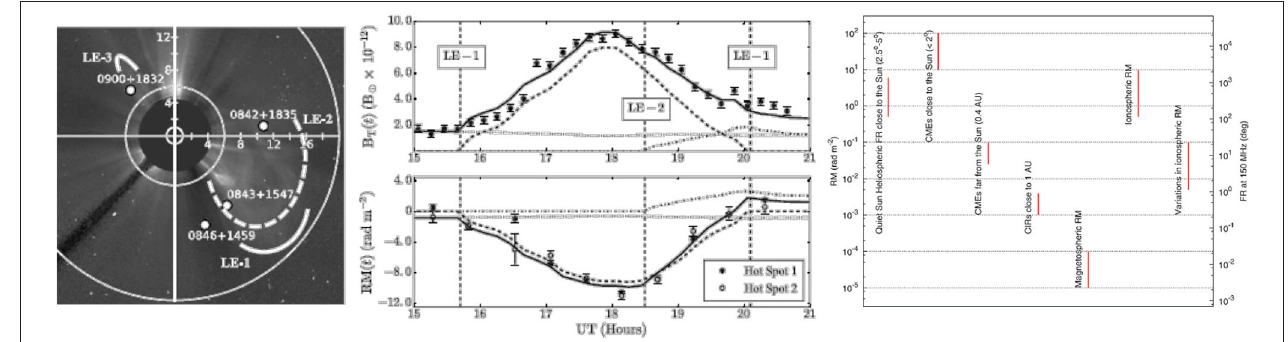
FIGURE 5 | Left : LASCO observations at the time (19:06 UT) of the 0843 radio source occultation by two CMEs (CME-1 and CME-2) on Aug. 2, 2012. Middle : Thomson-scattering brightness (top) and coronal RM (bottom) for 0843. The Thomson brightness is given for one line-of-sight to the target source center (see Kooi et al., 2017 for details on Hot Spot 1 and 2). The dotted curve represents the background coronal model, the dashed curve represents the flux-rope model for CME-1, the dash-dotted curve represents the flux-rope model for CME-2, and the solid curve represents the sum of the contributions from all models together. The LE-1 vertical lines mark the times of the radio source occultation by CME-1 (15:42 UT and 20:06 UT, respectively). LE-2 marks the start of CME-2 occultation (18:30 UT) (Adapted from Kooi et al., 2017 with permission by Springer Nature). Right : Overview of the RM effects from various plasmas. The corresponding FR (in deg) at 150 MHz is also indicated. A ± range of a factor of 2 has been assumed where needed. Adapted from Oberoi and Lonsdale (2012) with permission by the AGU.